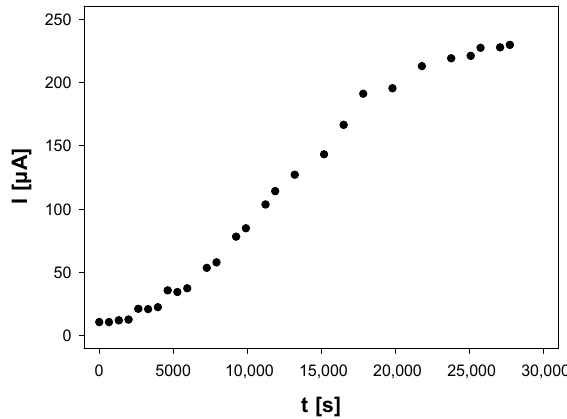
Figure 1. Chronoamperometric curve of silver wire electro-dissolution in the aqueous system. The applied potential: 3.5 V vs. quasi-reference glassy-carbon electrode, T = 15 °C, no supporting electrolyte.